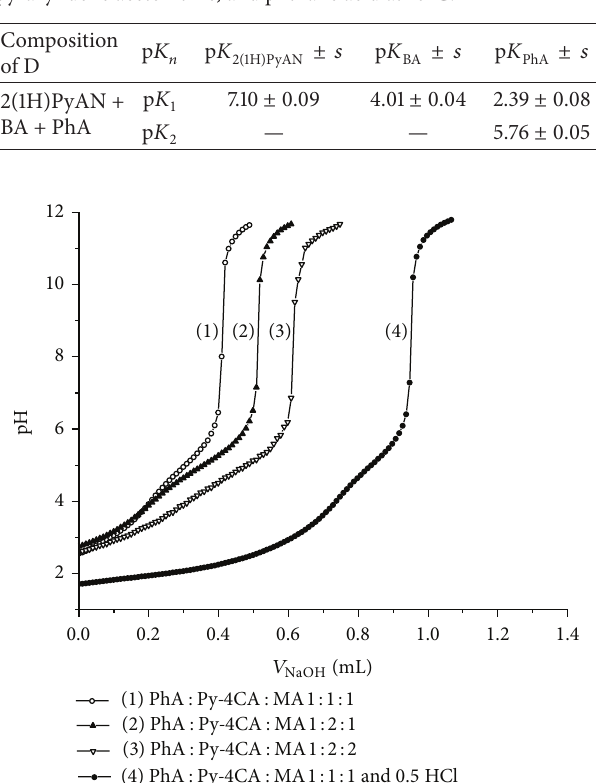
Figure 1: Titration curves pH = 𝑓(𝑉 of PhA, Py4CA, and MA with different mole ratio of acids and with excess of HCl.